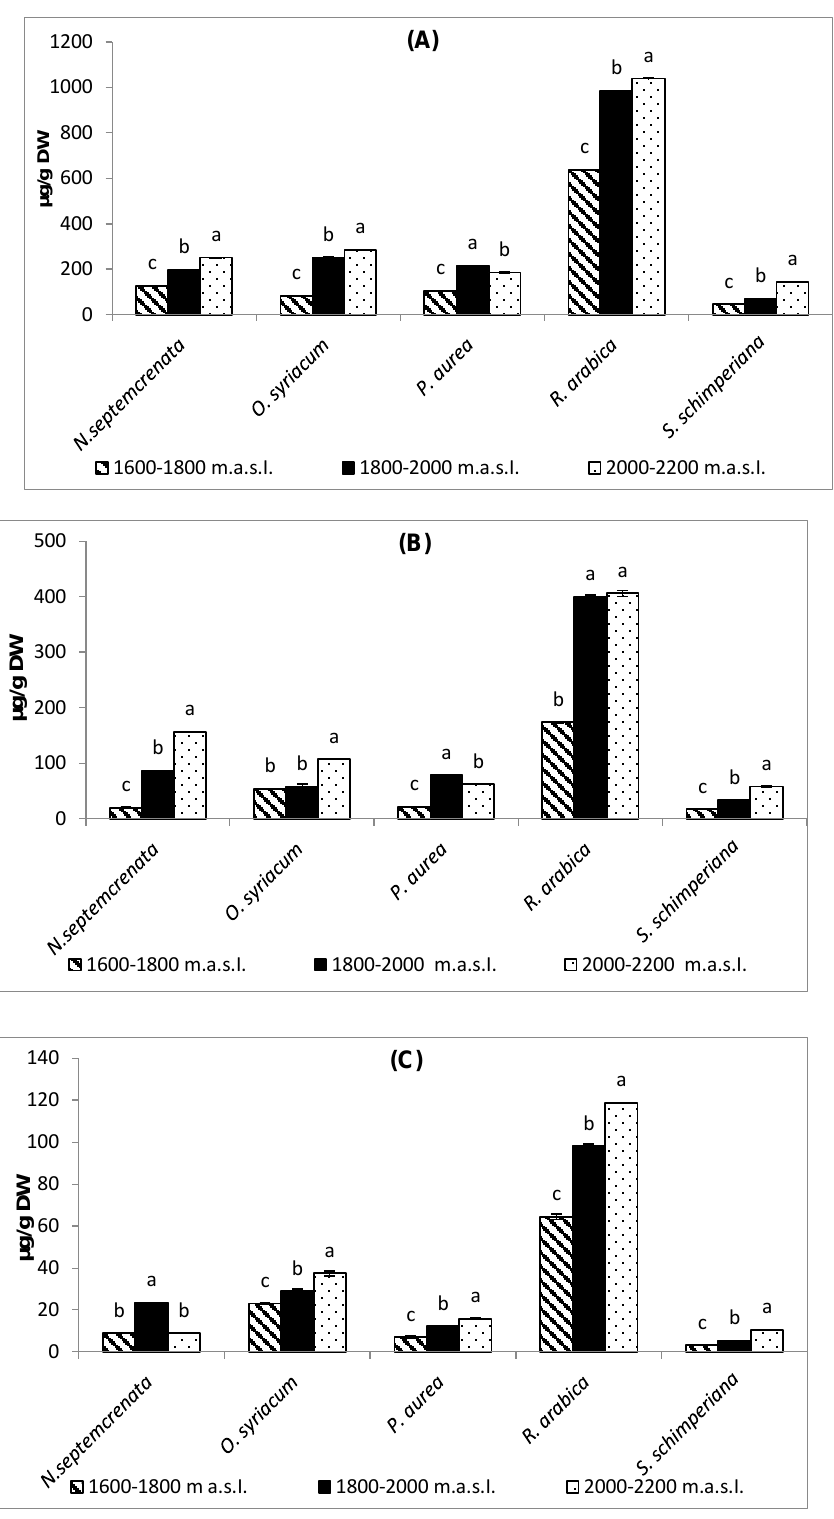
Figure 2. Effect of altitude on the contents of total phenols ( A ), flavonoids ( B ), and tannins ( C ). Each value is the mean of three replicates ± SE. Bars with different letters are significantly different at p ≤ 0.05.